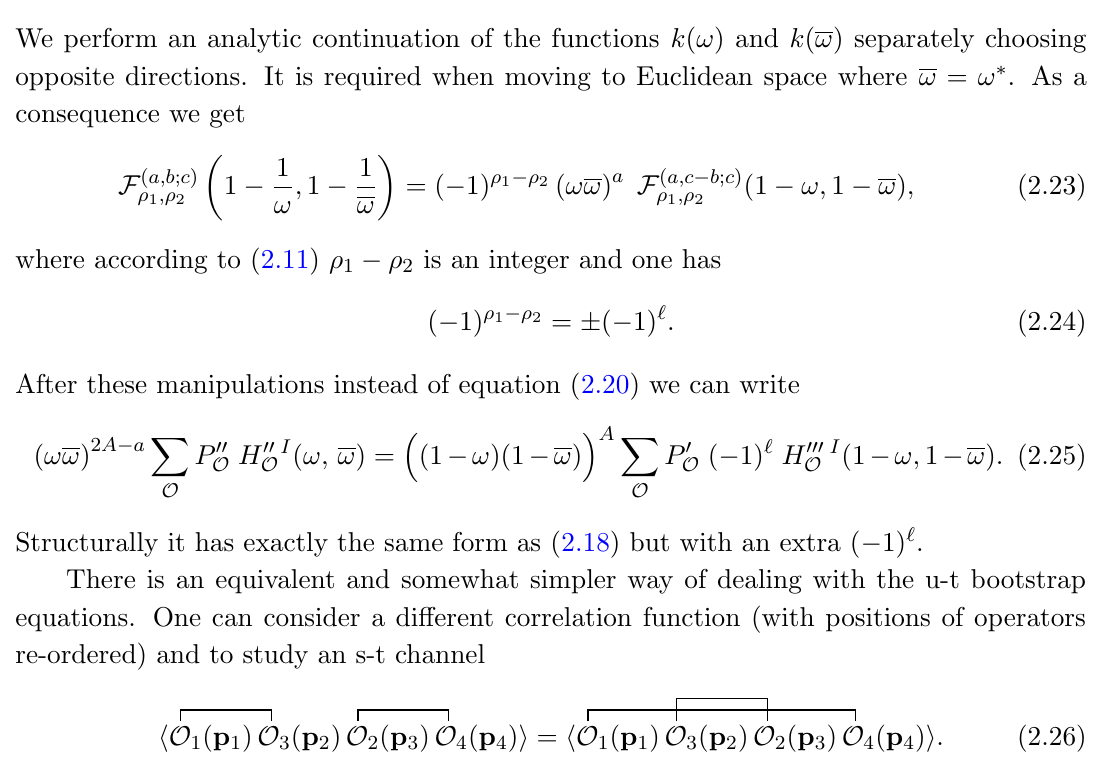
Figure 1 . Complex plain w . There are two branch cuts for the k function: one is due to the hypergeometric series and another one due to the power-law behavior. By circular arrows we show 2 di(cid:11)erent ways to perform an analytic continuation from the ! 2 [0 ; 1] to the [ (cid:0)1 ; 0]